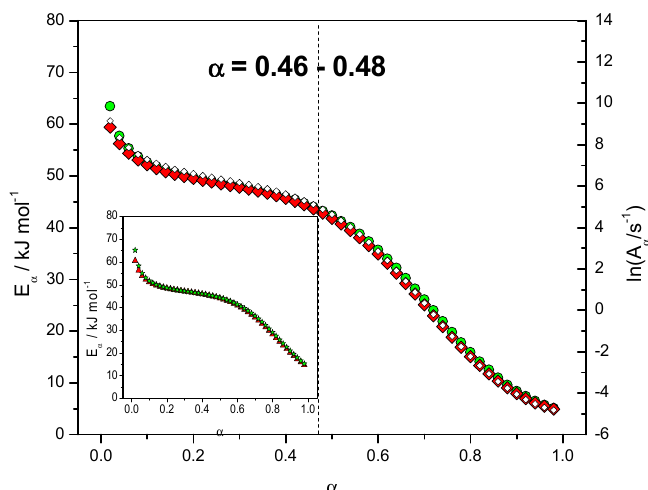
Figure 4. Dependence of the effective activation energy ( E α ) and pre-exponential factor (ln A α ) with the extent of conversion ( α ). Non-isothermal data. Open lozenges: pre-exponential factor, red solid lozenges: E α computed with FR method, green circles: E α computed with NLN method. Inset: isothermal data. Solid triangles: E α computed with FR method, solid stars: E α computed with NLN method.